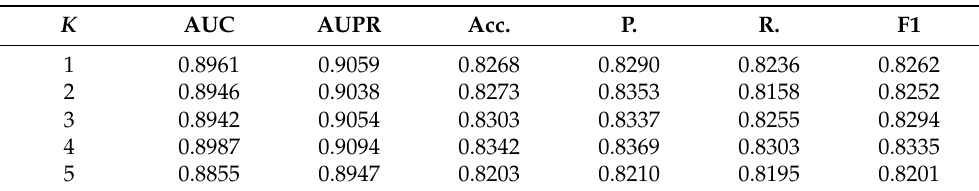
Table 2. Prediction results of LRGCPND with different depth K .